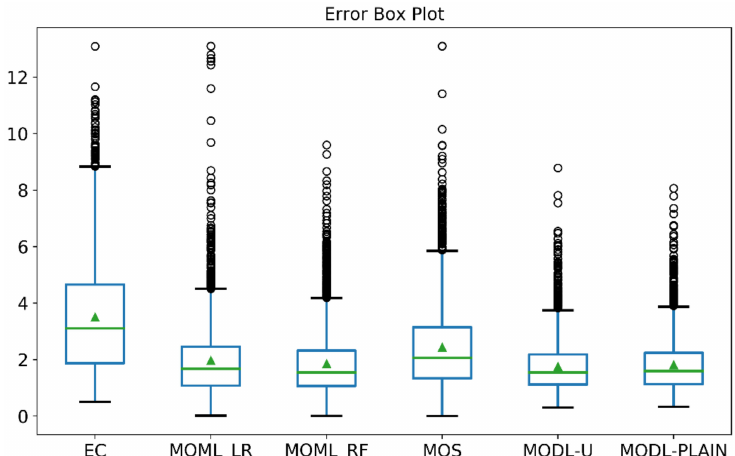
Figure 11. Error box plot. Each box plot corresponds to the distribution of a model forecast error. The ordinate of the green line in the box is the median of the error distribution, and the ordinate of the green triangle is the mean of the error distribution. The upper and lower sides of the box are the upper quartiles (Q3) and lower quartiles (Q1) of the error distribution. The two horizontal lines on the outside of the box are the maximum and minimum values of non-abnormal error data. Each circle represents an abnormal